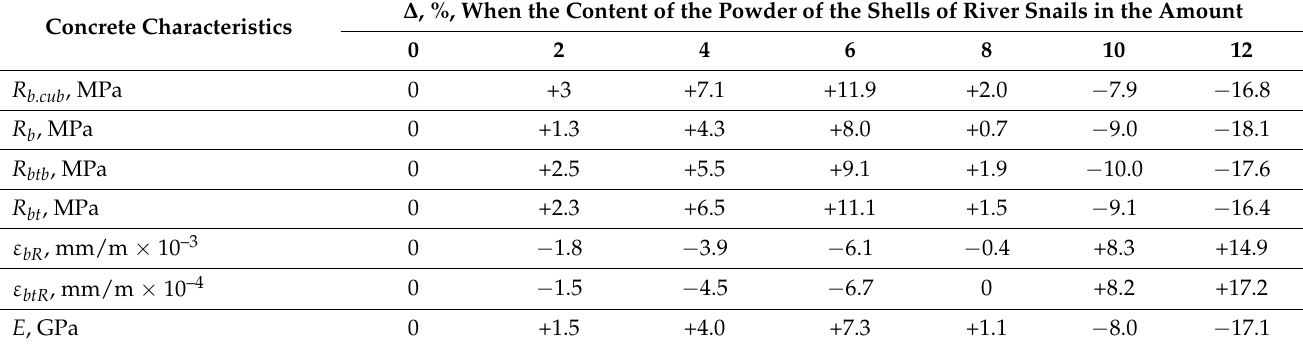
Table 6. Changes in characteristics of concrete depending on the dosage of snail shell powder ( ∆ ). Concrete